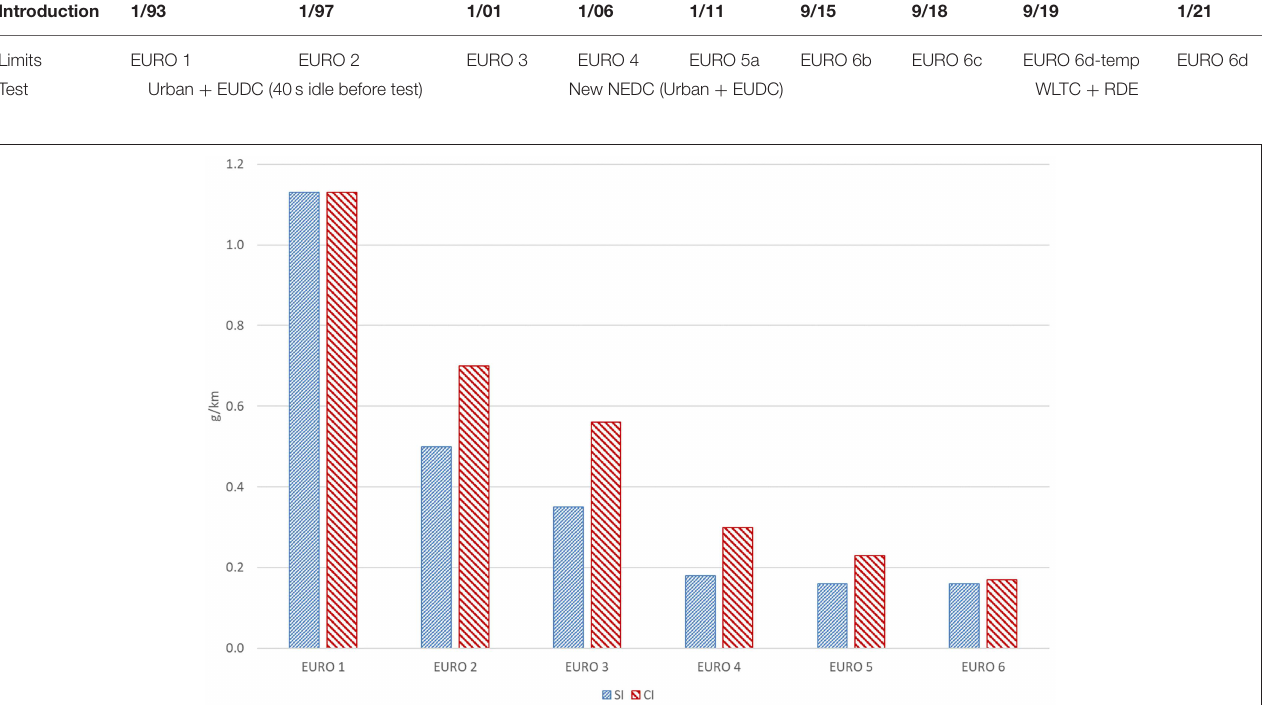
TABLE 1 | Emission limits for passenger cars (DELPHI Technologies, 2018).